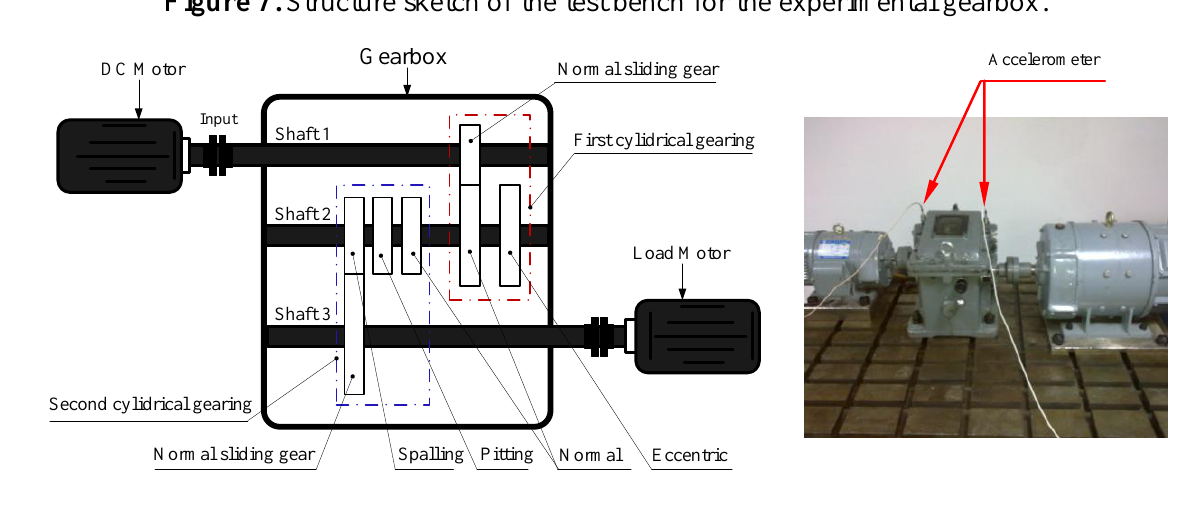
Table 1. Parameters of gear transmission